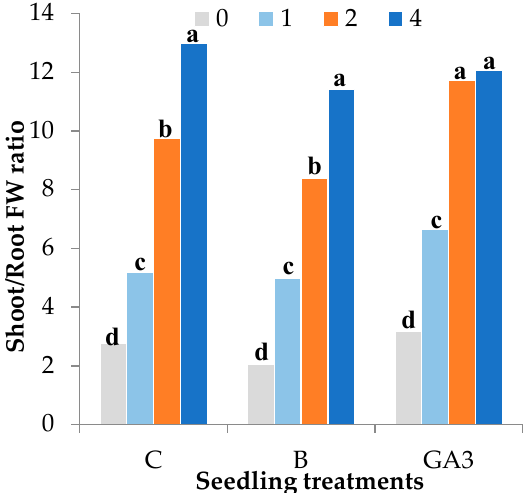
Figure 3. E ff ect of the seedling treatments (C, untreated control, B, bacterial biostimulant, GA3, gibberellic acid spray 10 − 5 M) and the fertigation rates (0, 1, 2 and 4 g L − 1 of NPK 20-20-20) on the shoot / root fresh weight ratio of Solanum lycopersicum ‘Marmande’ seedlings (bars with di ff erent letters are significantly di ff erent at p < 0.05 according to the LSD test).